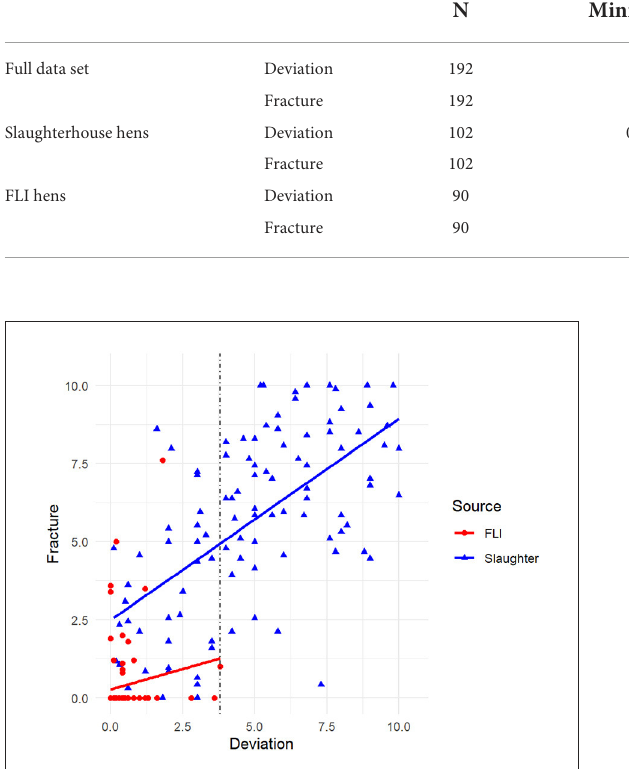
FIGURE2 Correlation between deviation and fractures assessed from 192 radiographs of laying hen keel bones sampled at the slaughterhouse (blue) and FLI (red). The vertical dotted line indicates the deviation score threshold of 3.8 from which onwards fractures were always